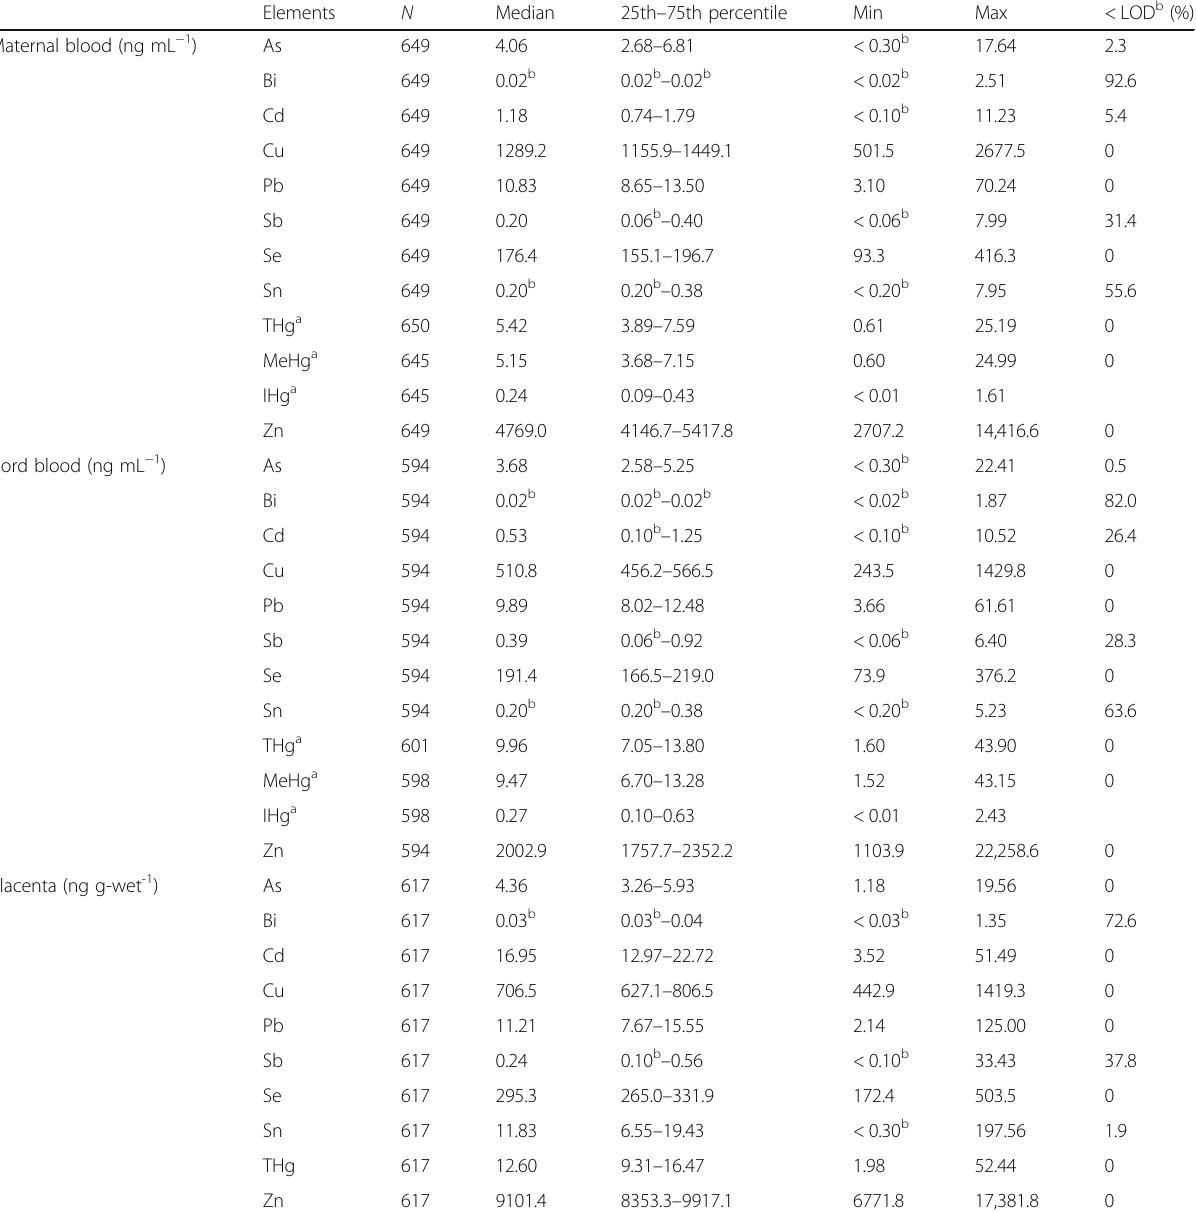
Table 2 Exposure levels of toxic and essential trace elements in the maternal blood, cord blood and placenta Elements N Median 25th – 75th percentile Min